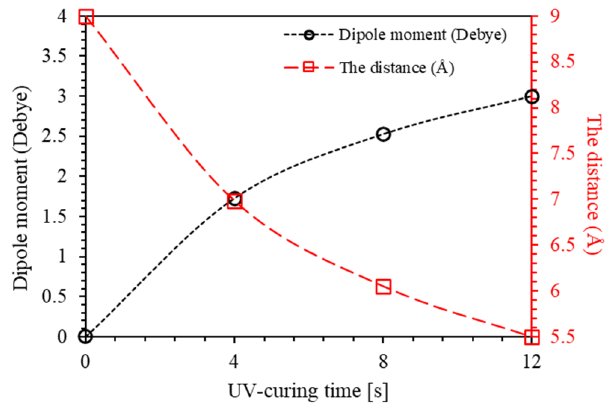
Figure 7. The distance between the two carbon atoms in position 4 of the aromatic rings and the dipole moment of MR in for PMMA-BDK-MR polymer composite thin film for various UV-illumination times.